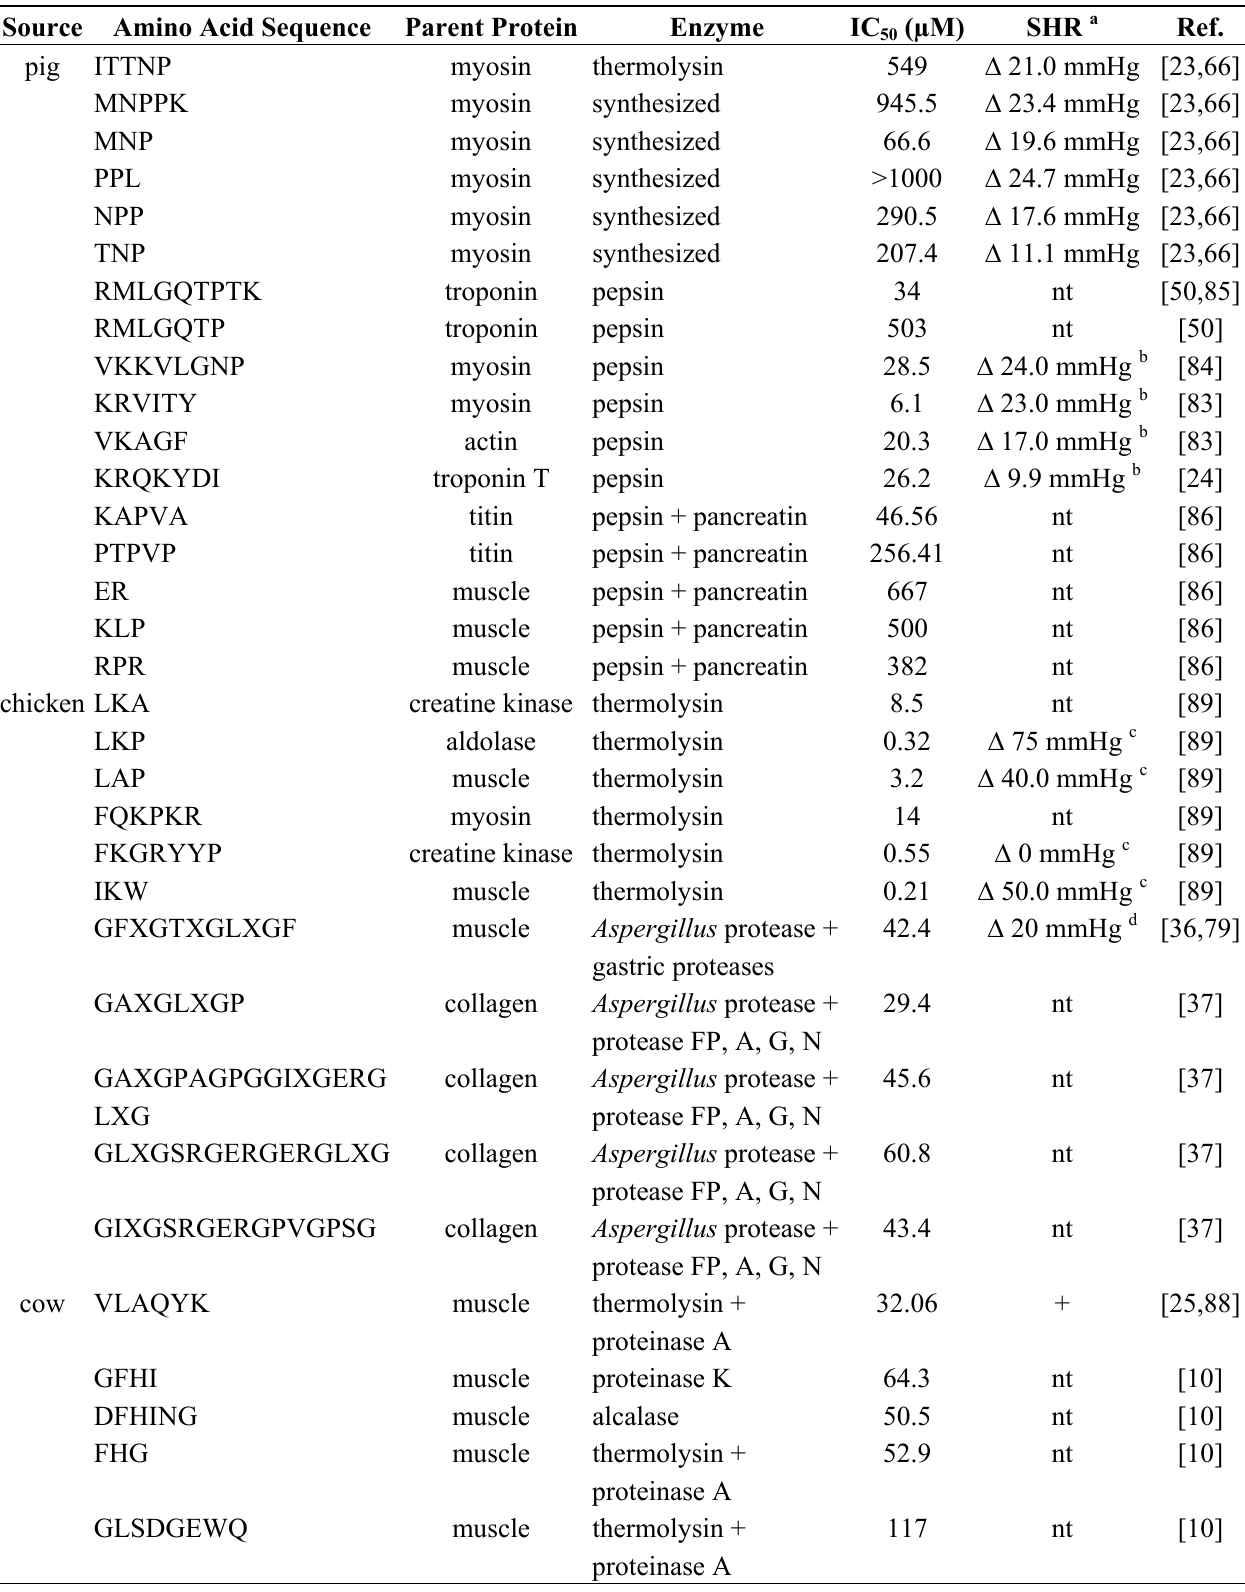
Table 1. ACE inhibitory peptides from meat of domestic animals. Adapted with permission from American Chemical Society [3], Copyright